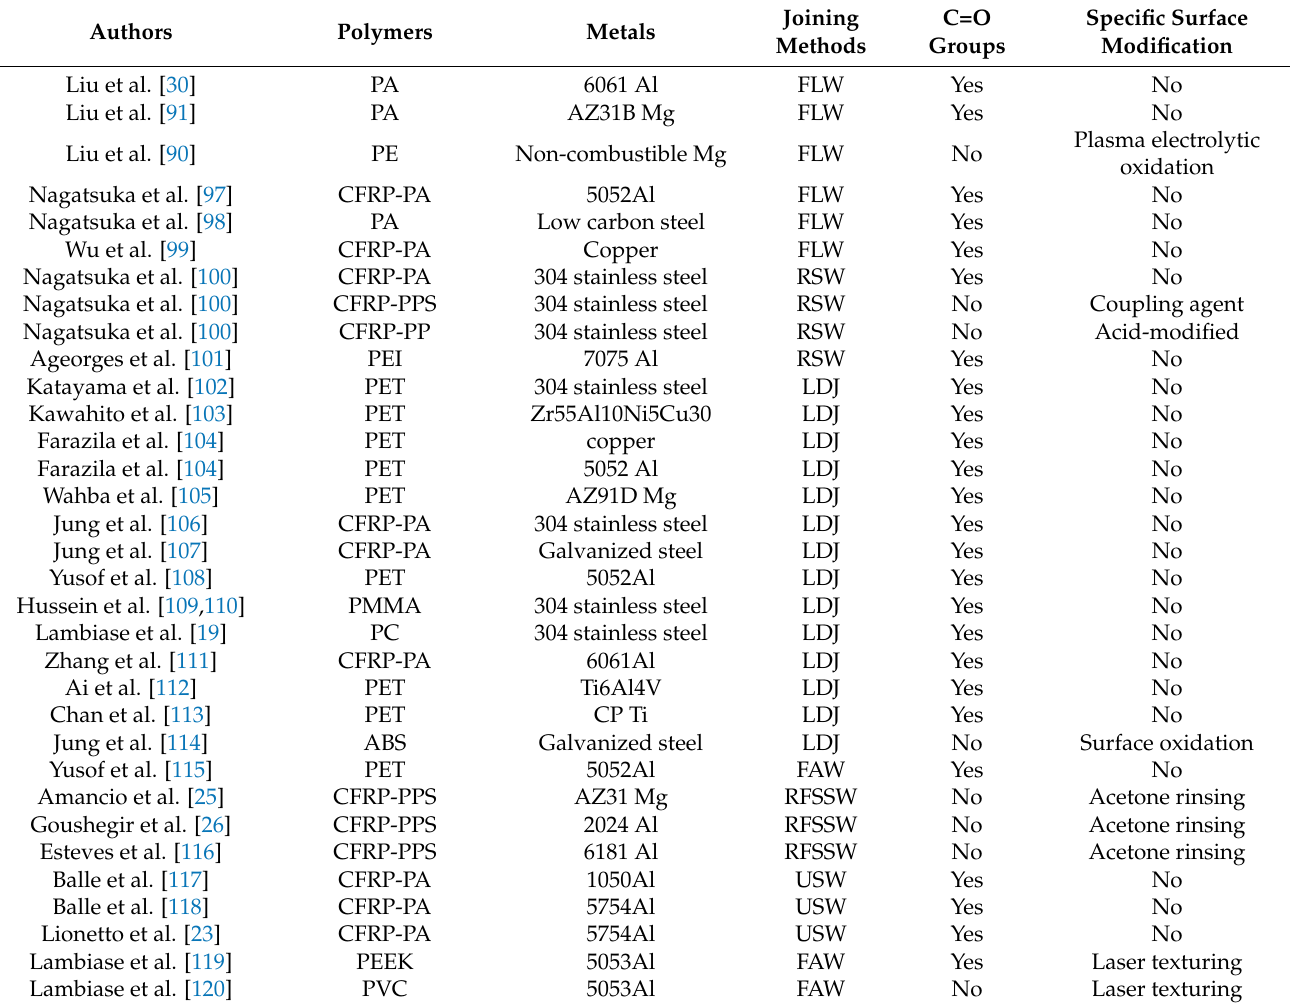
Table 2. A summary of the joinability of metal and polymer